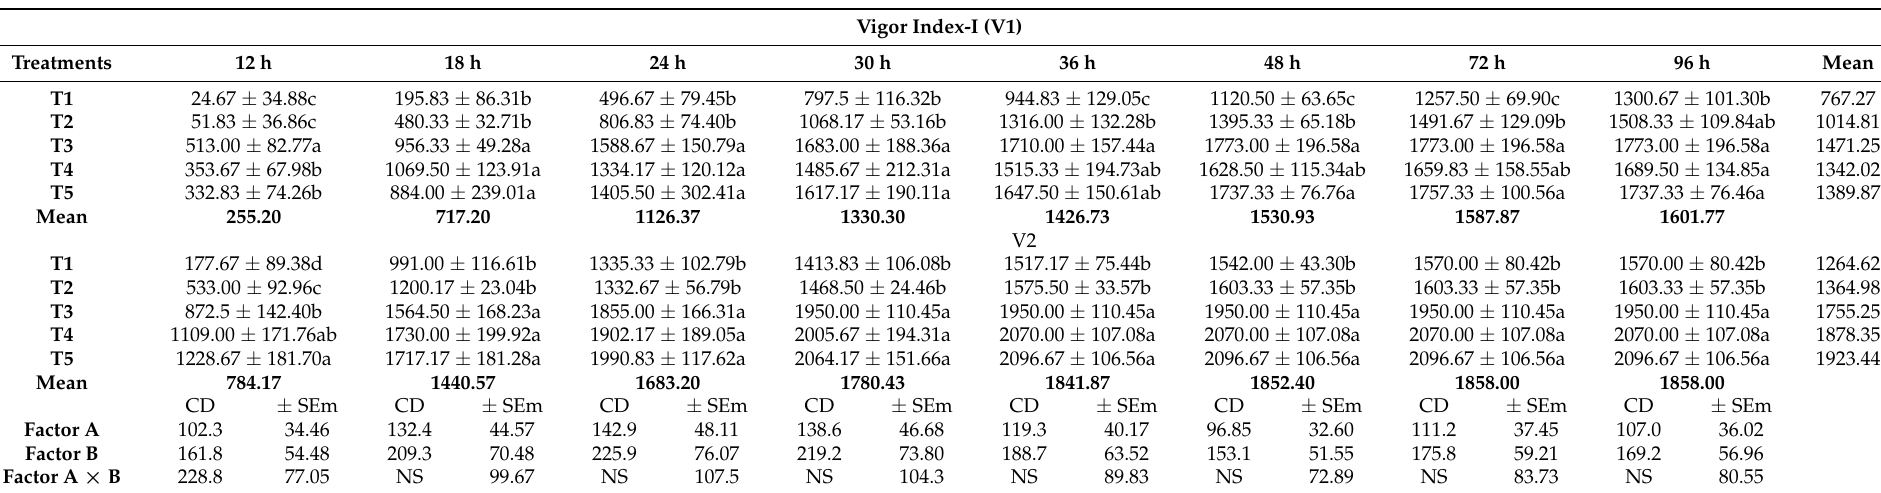
Table 2. Effect of hydro, Mg(NO 3 ) 2 , ZnSO 4 , Mg(NO 3 ) 2 + ZnSO 4 primed, and nonprimed (control) seed treatments on vigor index-I, grown in the year